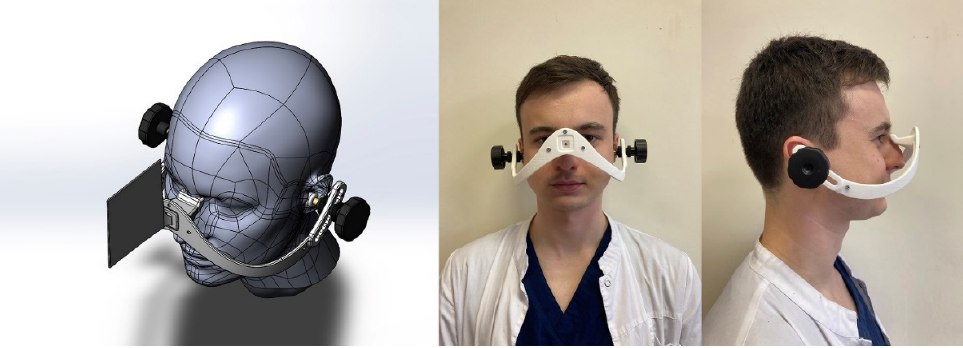
Figure 6. Design of a polyamide facial frame.